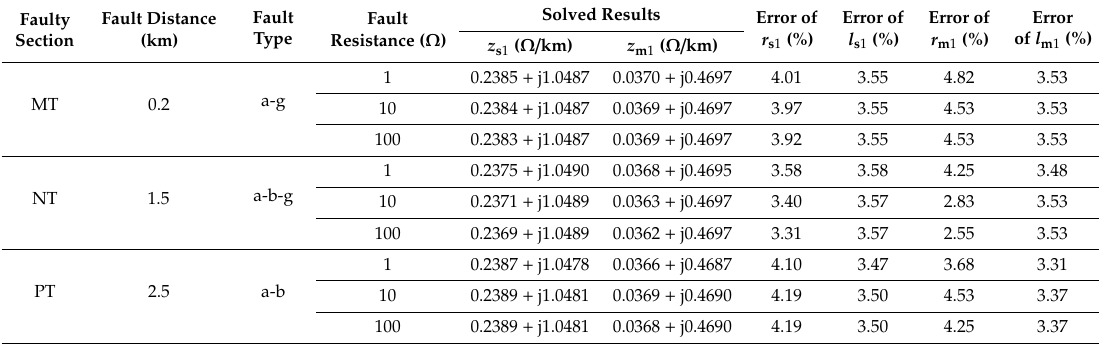
Table 4. The calculated line parameters for typical fault conditions.